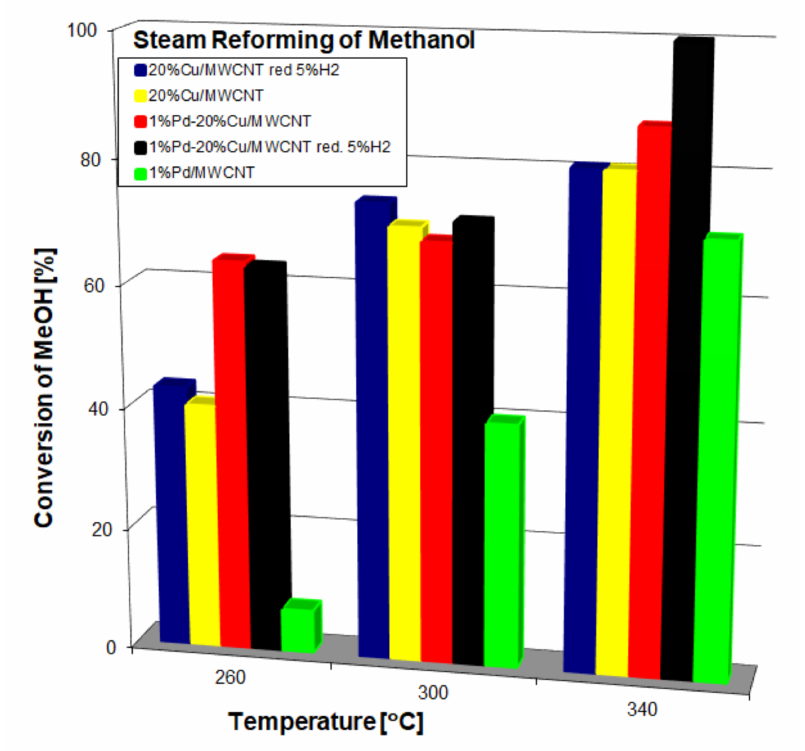
Figure 4. The methanol conversion results obtained for the monometallic and bimetallic catalysts during the steam reforming of methanol